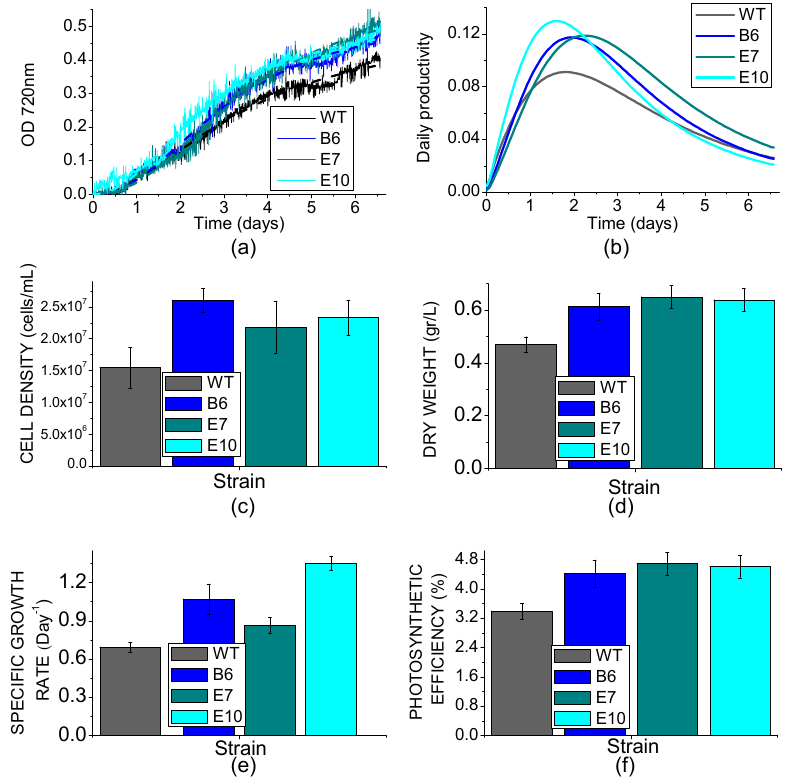
Figure 8. Biomass productivity in photobioreactors. ( a ): growth curves of WT and transformed lines obtained by measuring the optical density (O.D.) at 730 nm.. Growth curves were fitted with an exponential growth function; ( b ): daily productivity estimated from the first derivate of the fitting curves reported in ( a ); ( c ): cell density obtained at the end of the growth curve; ( d ): dry weight obtained at the end of the growth curve; ( e ): specific growth rate ( μ ) for WT and transformed lines; ( f ): photosynthetic efficiency of WT and transformed lines calculated from dry weight obtained at the end of growth curve. Mean value of three independent measurements are reported. Standard deviation are reported as error bars ( n =